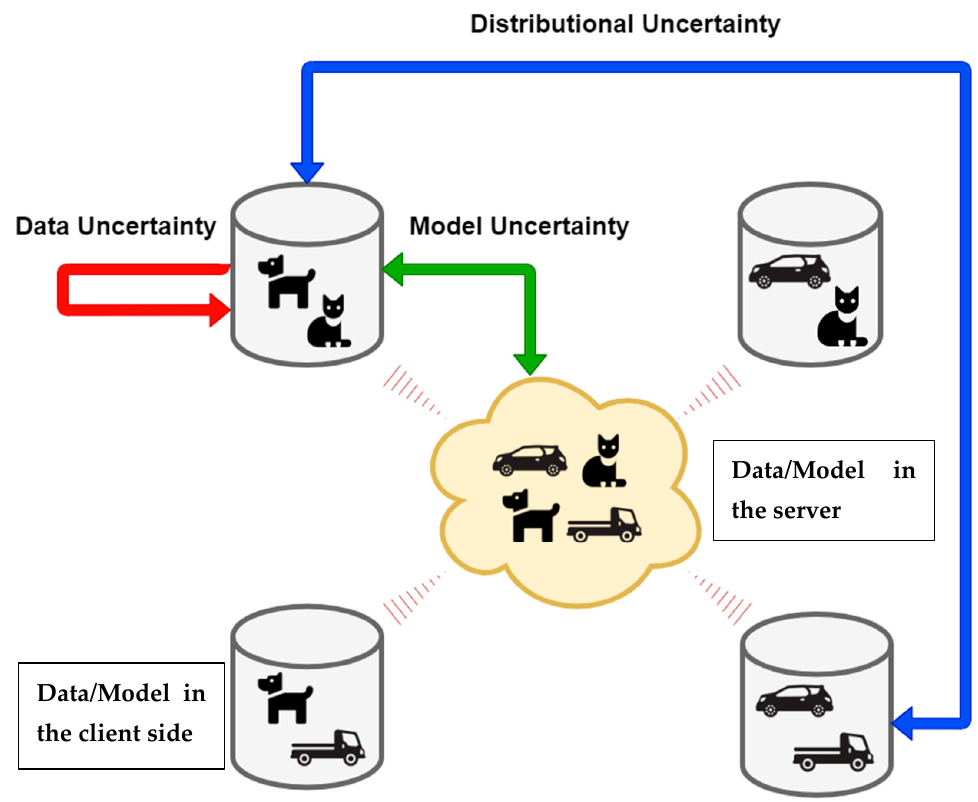
Figure 4. NN Uncertainties under the structure of federated learning.